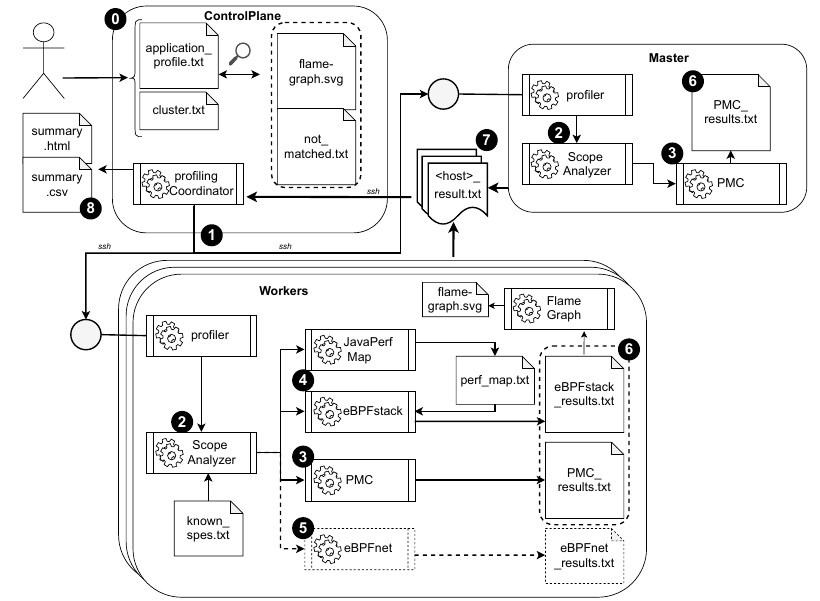
Figure 1. Conceptual architecture of the measurement